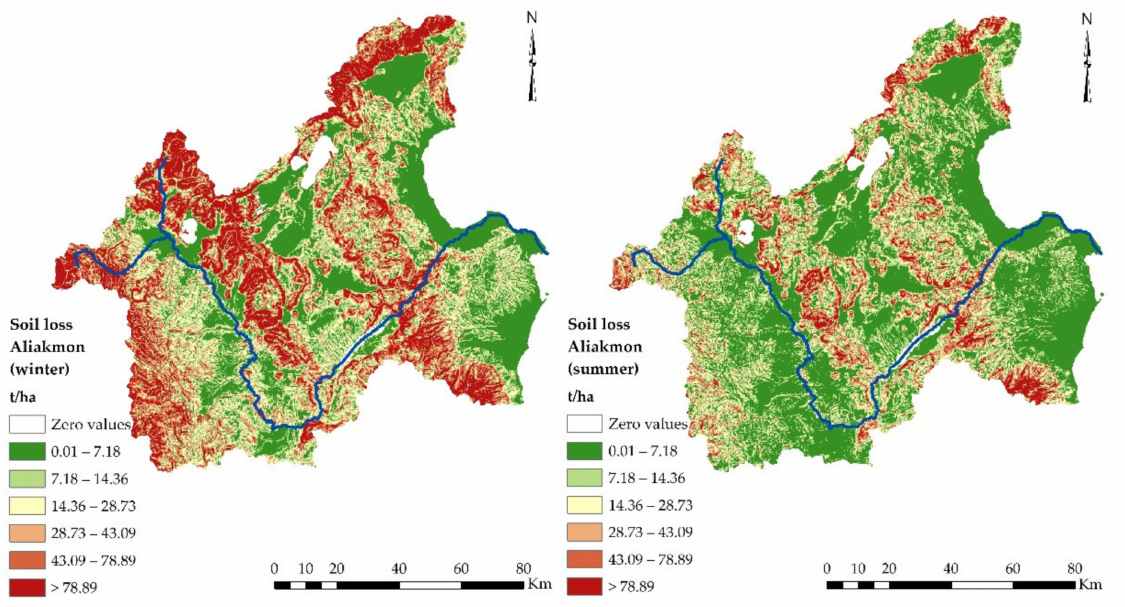
Figure 16. Average seasonal soil loss for the Aliakmon catchment area during winter ( left ) and summer ( right